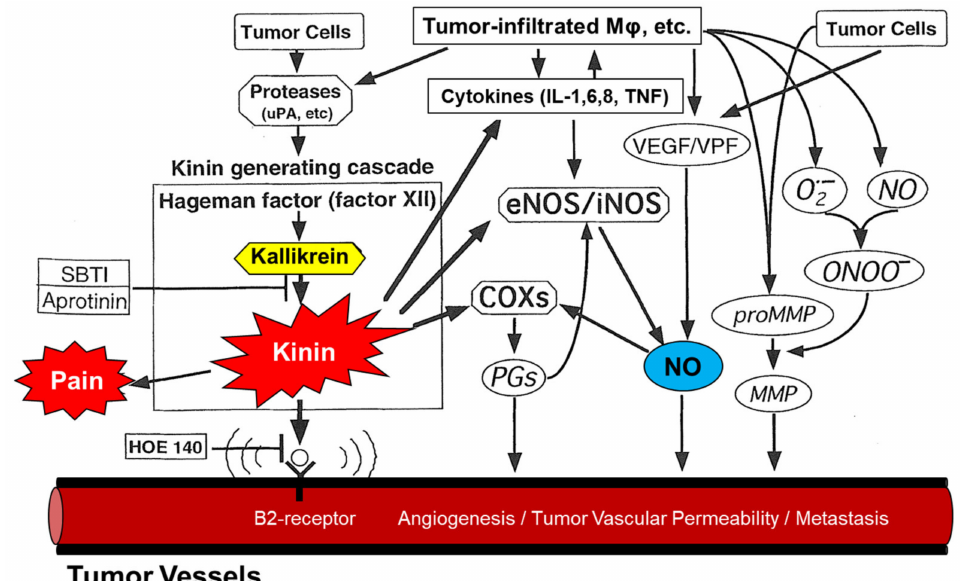
Figure 2. The enhanced permeability and retention (EPR) effect in tumor vasculature. The mechanism of this tumor-selective macromolecular drug targeting depends on various effectors affecting vascular tone as shown here. Aprotinin is an inhibitor of kallikrein; HOE-140 is a peptide antagonist of kinin. SBTI, soybean trypsin inhibitor; NO, nitric oxide; eNOS, endothelial nitric oxide synthase; iNOS, inducible form of nitric oxide synthase; COXs, cyclooxygenases; PGs, prostaglandins; MMP, metalloproteinase; ONOO - , peroxynitrite; O 2 − , superoxide anion radical; MF, macrophage; VEGF, vascular endothelial growth factor; VPF, vascular permeability factor; uPA, urokinase plasminogen activator; IL, interleukin; TNF, tumor necrosis factor; B2 receptor, bradykinin B2 receptor. Adapted from ref.